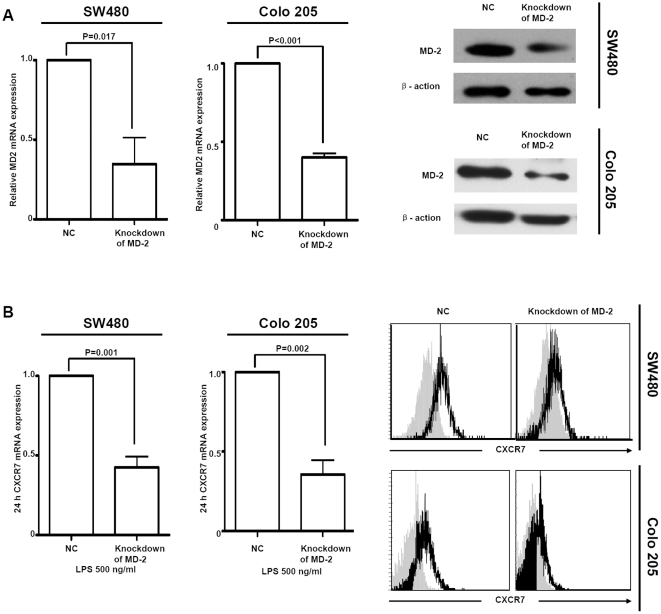
Knockdown effect of MD-2 on exposure of TLR4 to LPS in SW480 and Colo 205 cell lines.A, SW480 and Colo 205 cell lines were transfected transiently with siRNA or negative control sequence(NC). SW480 and Colo 205 cell lines transfected with the MD-2 siRNA sequence exhibited a marked reduction in MD-2 mRNA and protein level compared with NC. B, After LPS treatment, flow cytometry and real-time quantitative-PCR were performed. Knockdown of MD-2 inhibited LPS-mediated CXCR7 expression.